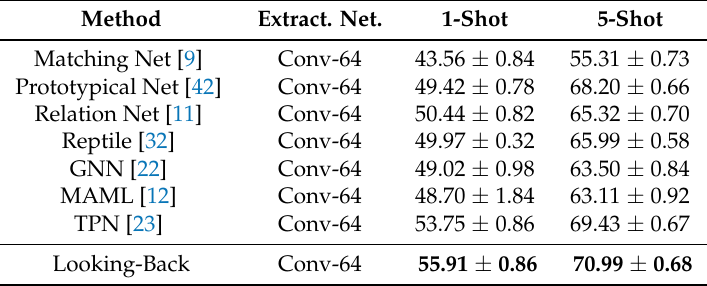
Table 1. Accuracy (in %) on mini ImageNet with 95% confidence interval. Best results are shown in bold.